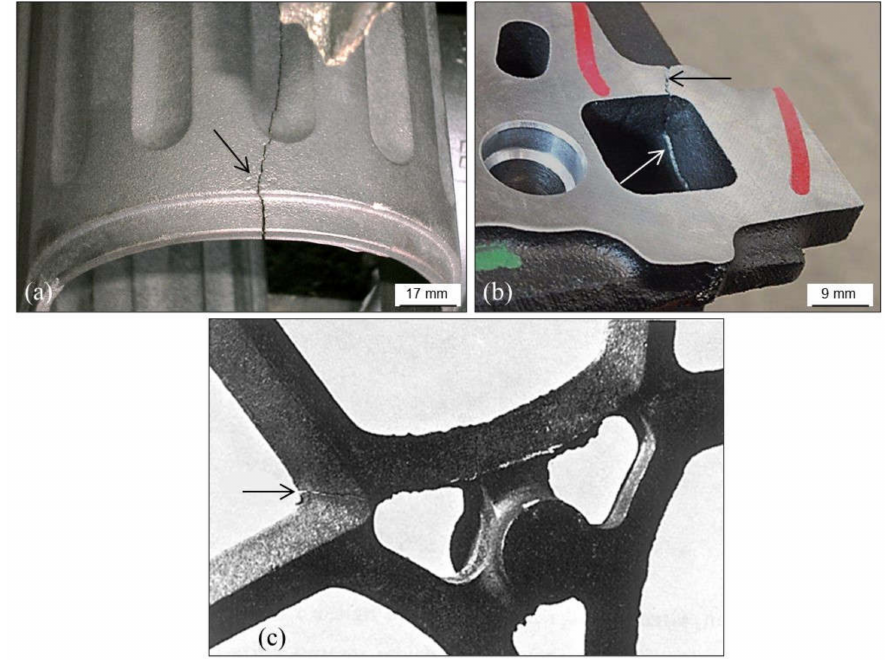
Figure 64. Cold tears found in ( a ) a grey iron casting with small sections, ( b ) a grey iron engine block and ( c ) a grey iron sewing machine wheel (Reprinted with permission from ref. [17]. Copyright 1999 American Foundry Society, page 140). All three castings were produced in green sand molds.